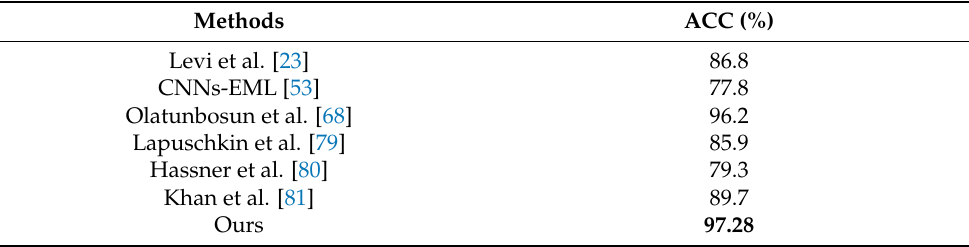
Table 8. Comparative gender estimation empirical results (ACC) for the Adience